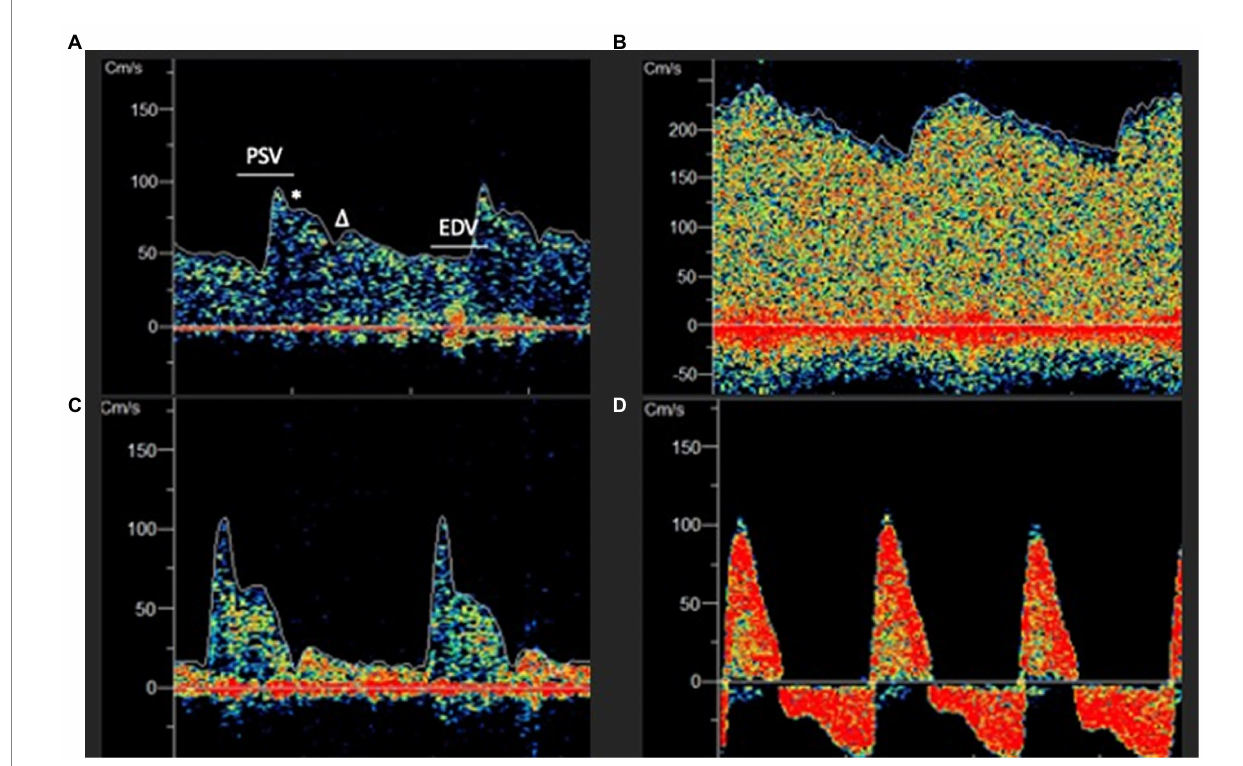
FIGURE 5 (A) Normal appearing low resistance TCD waveform. PSV, Peak systolic velocity; EDV, End Diastolic Velocity; * Windkessel Notch; ∆ Dicrotic Notch. (B) Hyperemic appearing waveform with elevated EDV, absent dicrotic notch and low pulsatility index (PI). (C) High resistance waveform with low EDV and elevated PI. (D) Extremely elevated intracranial pressure with peaked systolic upstroke and reversal of diastolic flow in a patient with cerebral circulatory arrest.